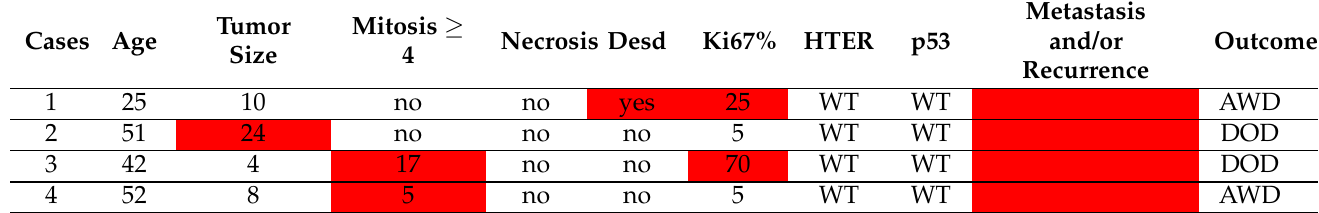
Table 9. Low-risk solitary fibrous tumor with poor evolution (N =